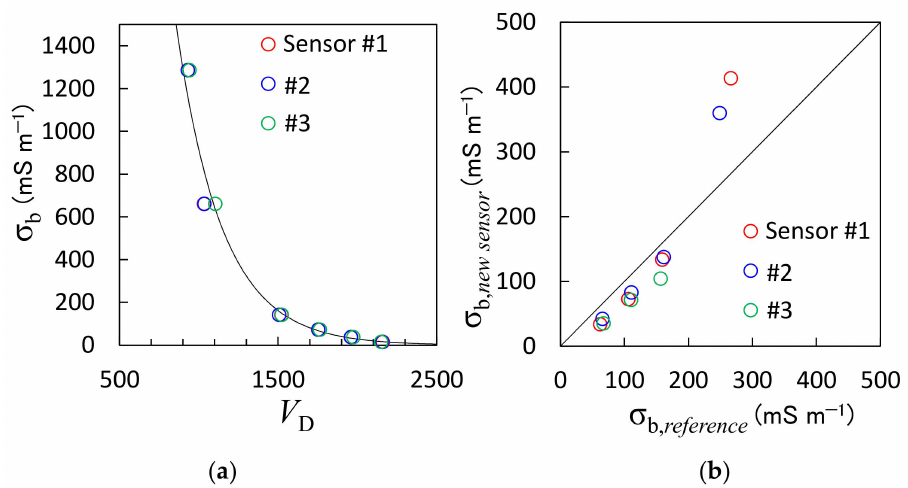
Figure 5. ( a ) Relationship between the electrical conductivity ( σ b ) of potassium chloride (KCl) solution measured with the reference sensor and the V D measured with the proposed sensor, and ( b ) comparison between the σ b of the Toyoura sand calculated with Equation (1) ( σ b, reference ) and the σ b determined using the proposed sensor ( σ b, new sensor ). The different colored plots represent different sensor